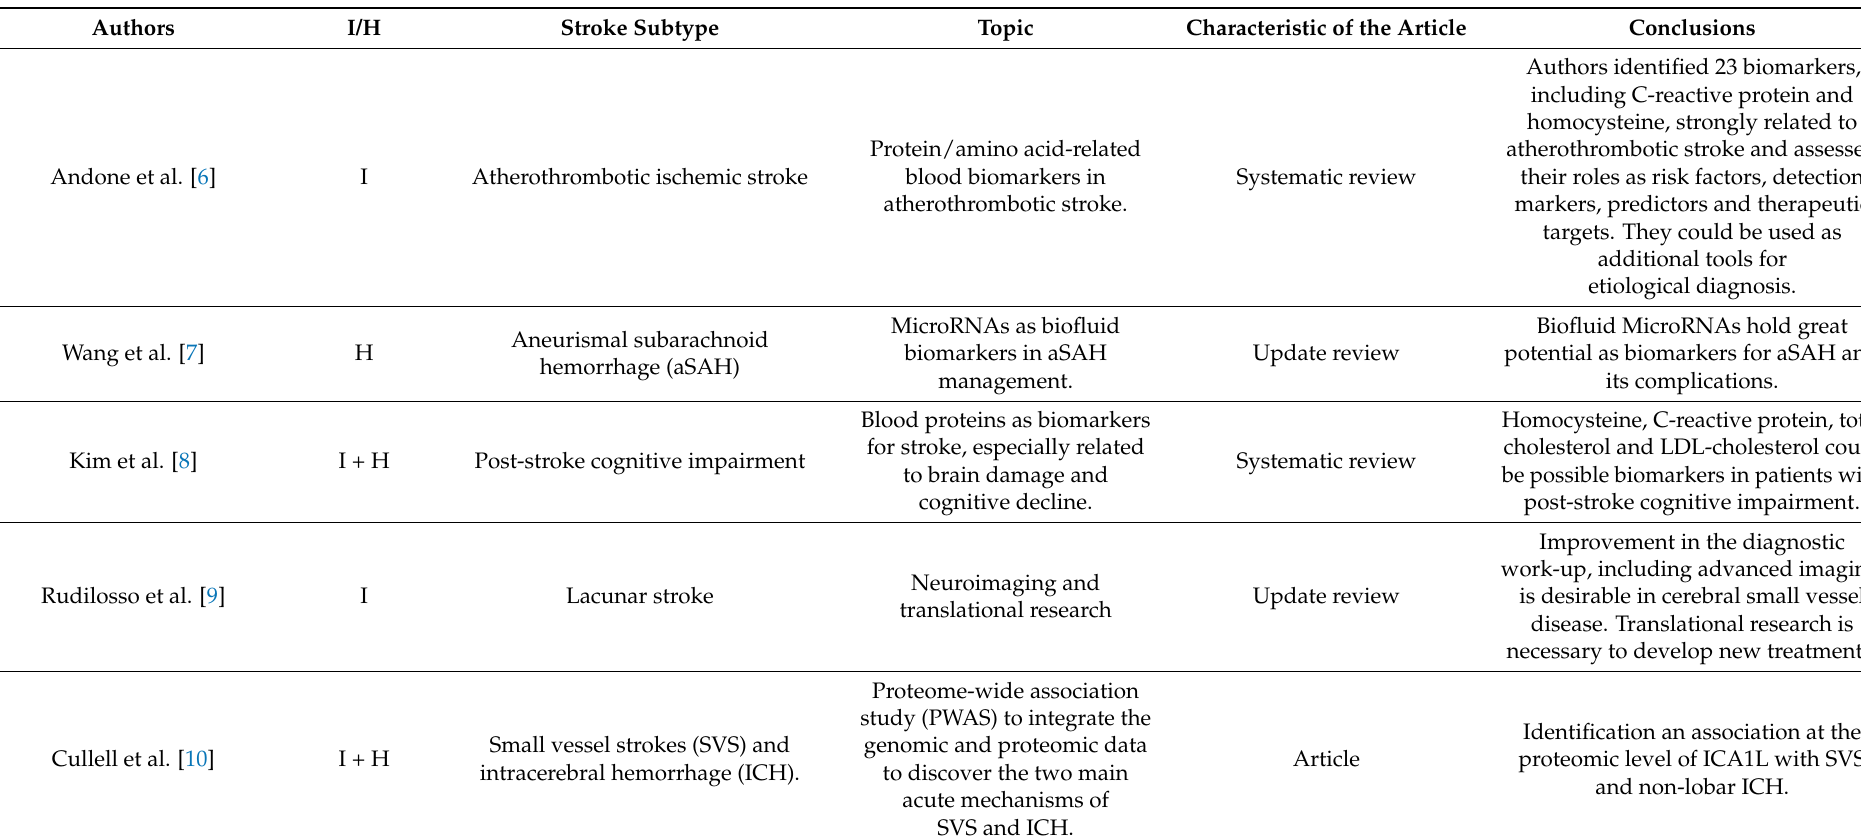
Table 1. Articles included in the present Special Issue “Molecular Mechanisms and Pathophysiology of Acute